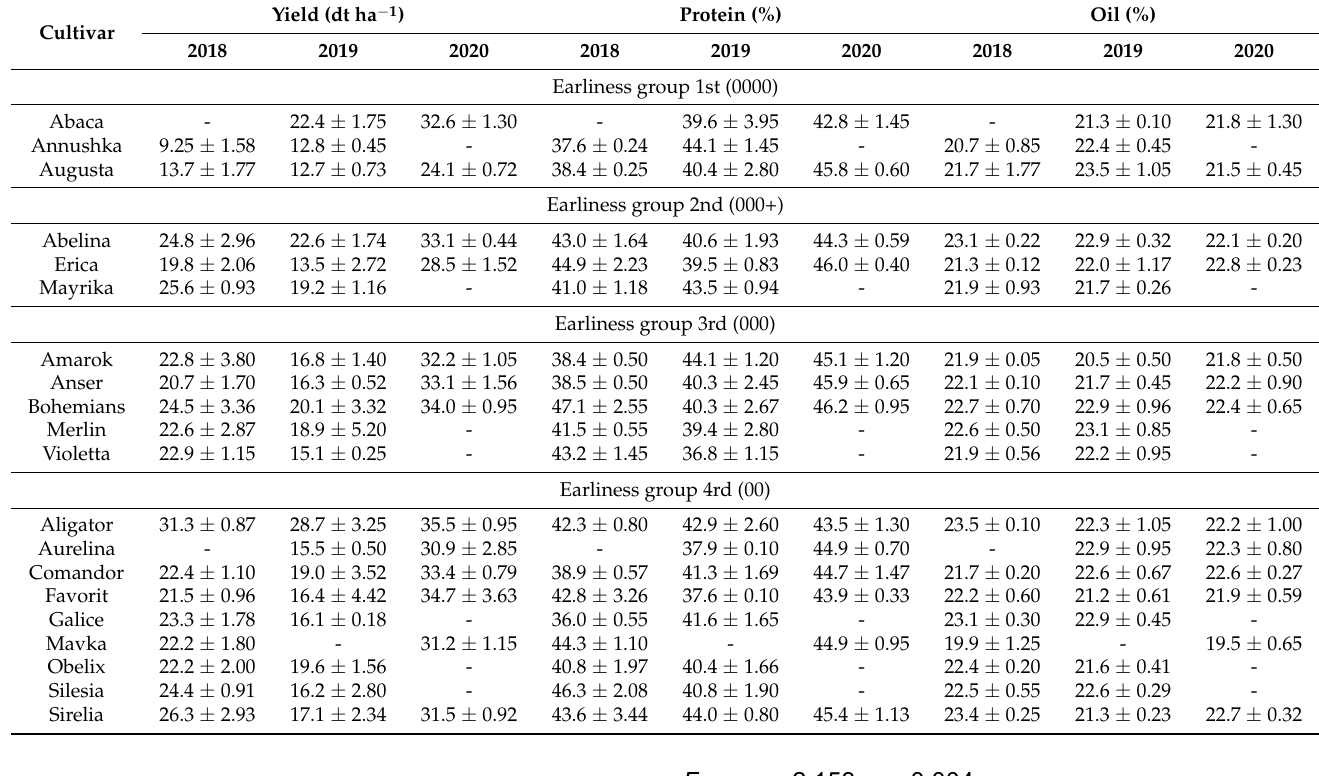
Table 7. Seed yield, protein content and oil content in seed depending on the soybean earliness, cultivars, and years of study. Mean ± standard error from the sites of study in Central Poland. Cultivar